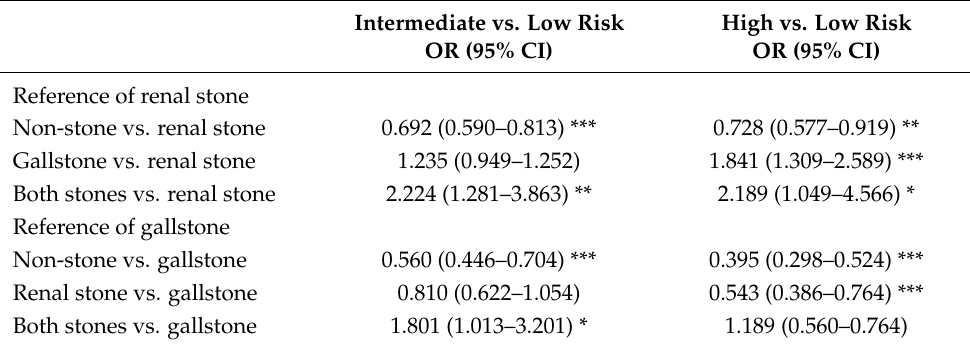
Table 3. Multinomial logistic regression models for the association of stone status with interme- diate and high levels of ASCVD risk, with a renal stone group and gallstone group, respectively, for